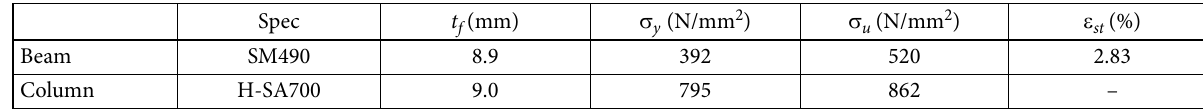
Figure 16. Shapes of the knee braces of the specimens (unit: mm): a – investigation of the slipping failure at the connection; b – investigation of the yielding at the knee braces Table 2. Material properties of the steel frames of test specimens